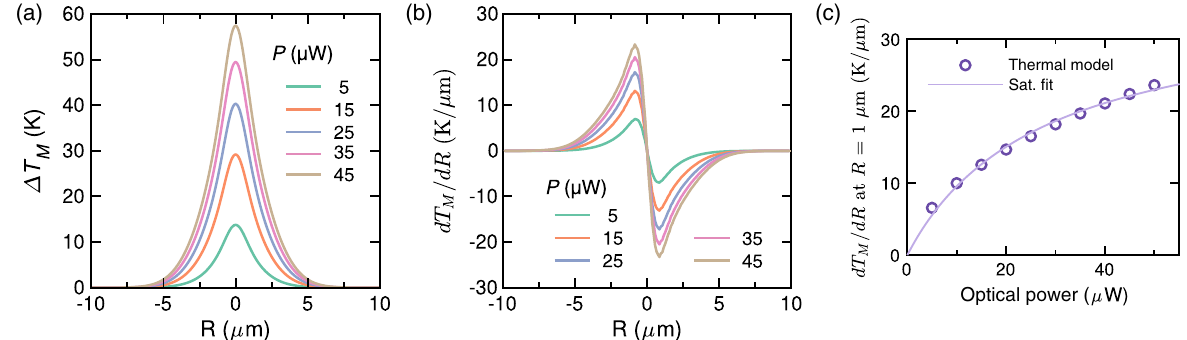
FIG. 8. Simulated temperature profile in 1 L -MoS 2 . (a) The temperature distribution T M ð R Þ in 1 L -MoS 2 at the end of an excitation pulse of optical power P lasting τ ¼ 7 . 6 μ s. The plotted y axis Δ T M ð R Þ is the rise in temperature from an initial uniform value of 9 K. (b) Spatial dependence of the thermal gradient dT M =dR for various optical powers. (c) Dependence of the thermal gradient at R ¼ 1 μ m, near the maximum of dT M =dR , versus optical power P . A sublinear, saturating behavior is observed in the simulations, in correspondence with the experimental data for the stray field measured by the NV [Fig. 3(c)].